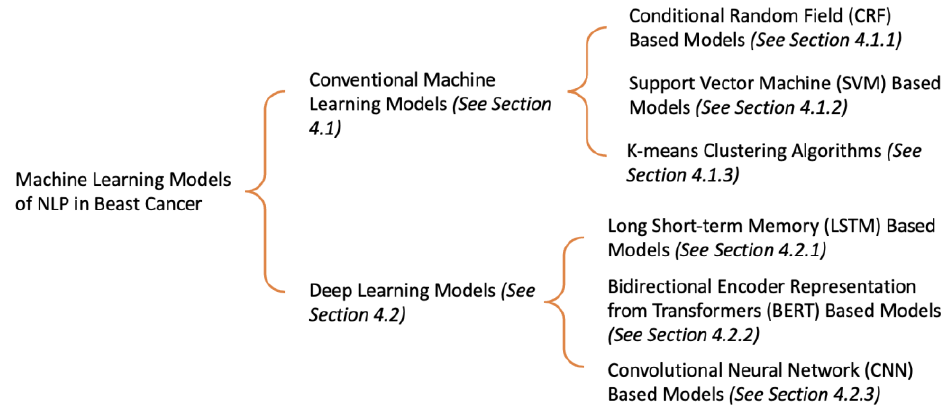
Figure 3. The overview of existing machine learning models of NLP in breast cancer.